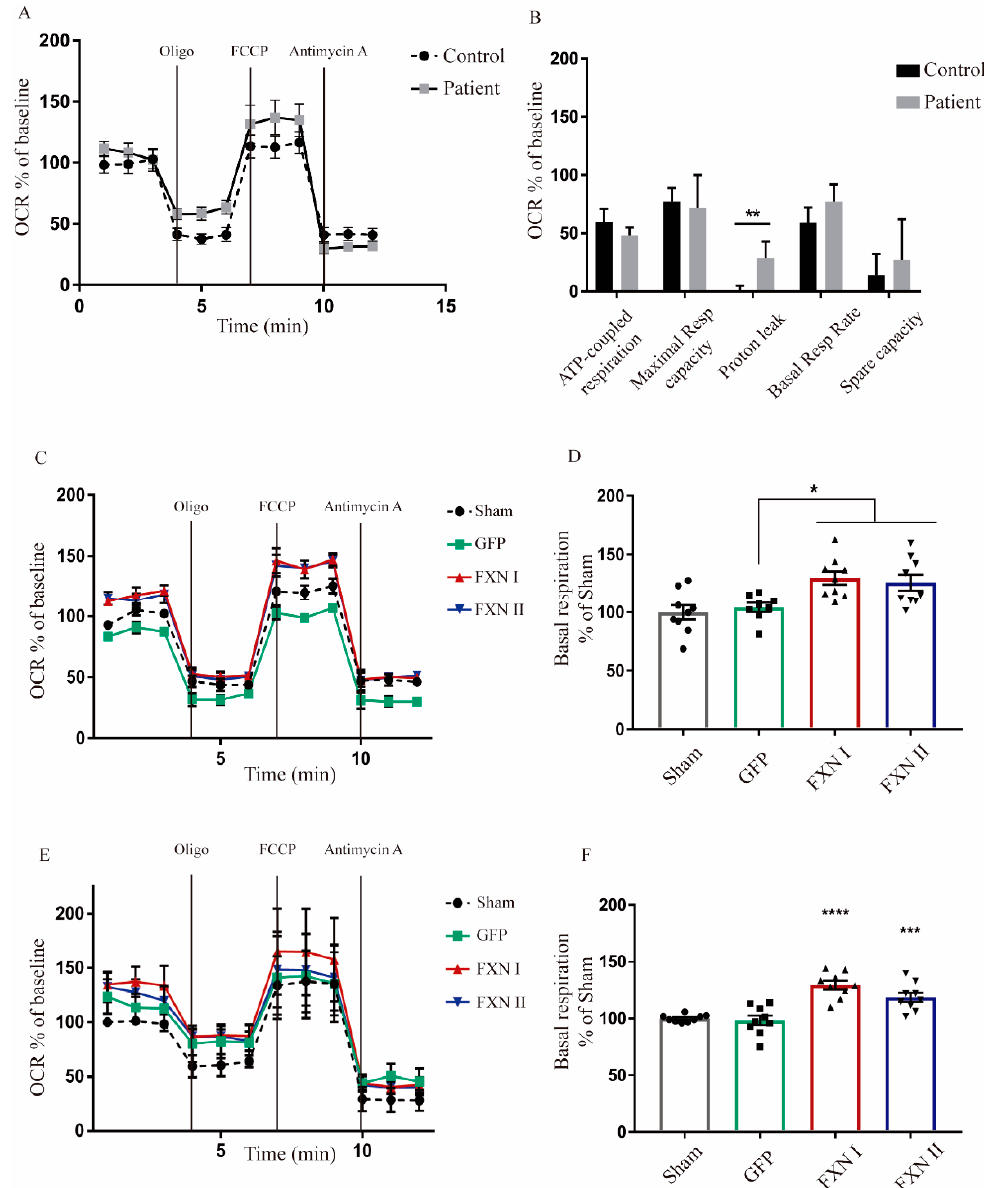
Figure 7. Seahorse assay in OEMS FRDA patients and healthy subjects. ( A ) Seahorse assay performed in untreated healthy and FRDA patient OE-MS cells showing oxygen consumption rates. The X-axis plots different measurements over time (rates). ( B ) Normalization of the seahorse results between healthy and patient OE-MSc showing differences in ATP-coupled respiration rate, maximal respiratory capacity, proton leak, basal respiratory rates and spare capacity. ( C ) Seahorse assay in healthy OE-MS cells either non-transduced or transduced with lentiviral vectors codifying for FXN I, FXN II or GFP as positive transduction control. The X-axis plots different measurements over time (rates). ( D ) Normalization of basal respiration levels in healthy OE-MS cells after transduction with frataxin isoforms. ( E ) Seahorse assay in patient OE-MS cells either non-transduced or transduced with lentiviral vectors codifying for FXN I, FXN II or GFP as positive transduction control. The X-axis plots different measurements over time (rates). ( F ) Normalization of basal respiration levels in FRDA patient OEMS cells after treatment with frataxin isoforms. Data are represented as mean ± SEM and were analyzed with a one-way ANOVA with post hoc Dunnett multiple comparisons test from at least three independent experiments from independent cell culture preparations ( n = 3). * p < 0.05; ** p < 0.01; *** p < 0.001; **** p < 0.0001.